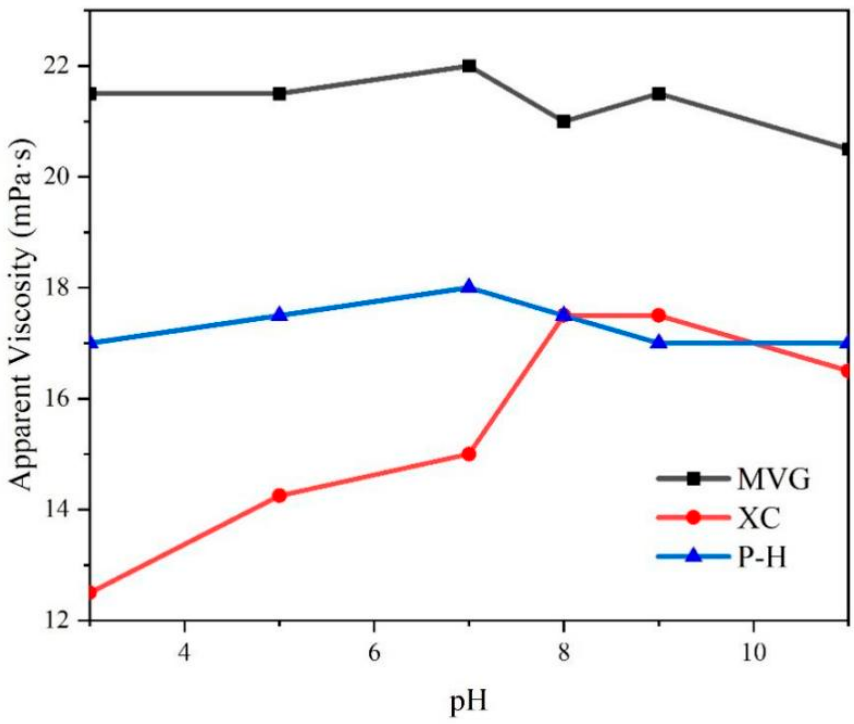
Figure 3. Apparent viscosity of the sea salt slurries containing natural high-molecular-weight polymers in a 0.5% concentration .